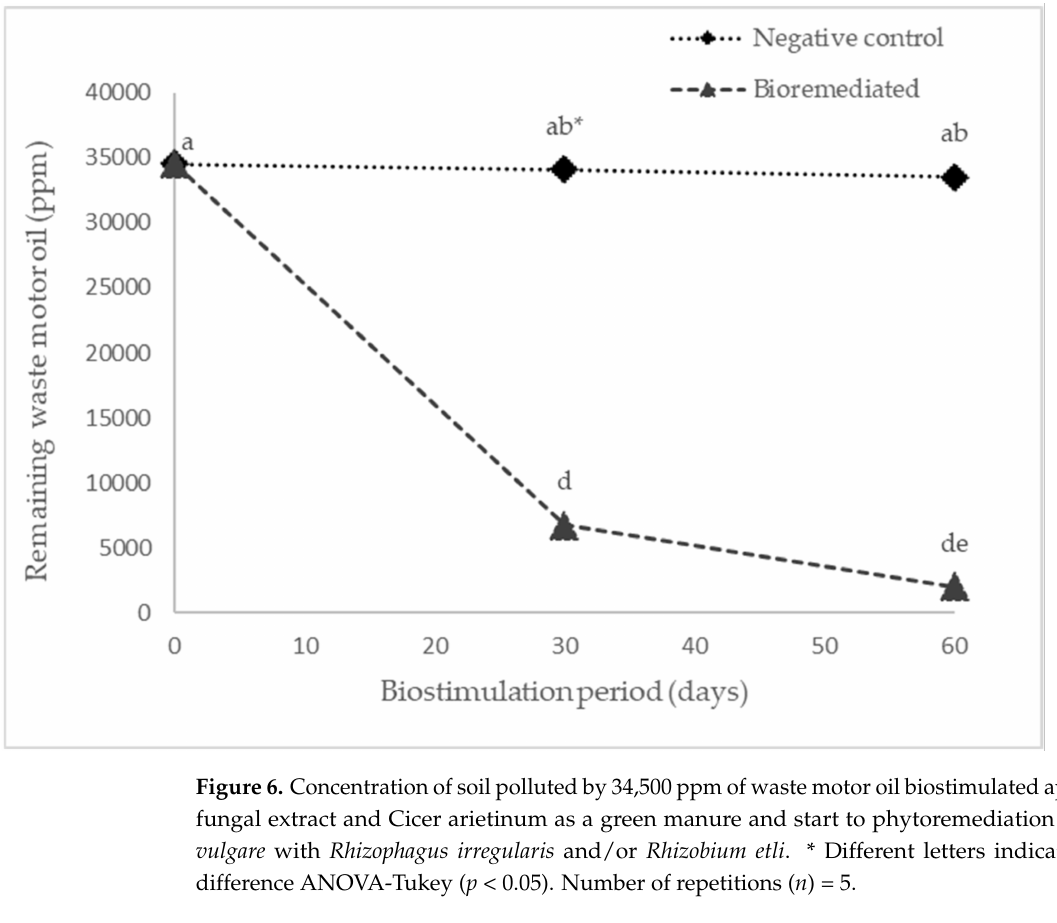
Figure 6. Concentration of soil polluted by 34,500 ppm of waste motor oil biostimulated applied crude fungal extract and Cicer arietinum as a green manure and start to phytoremediation by Sorghum vulgare with Rhizophagus irregularis and/or Rhizobium etli . * Different letters indicate statistical difference ANOVA-Tukey ( p < 0.05). Number of repetitions ( n ) = 5.